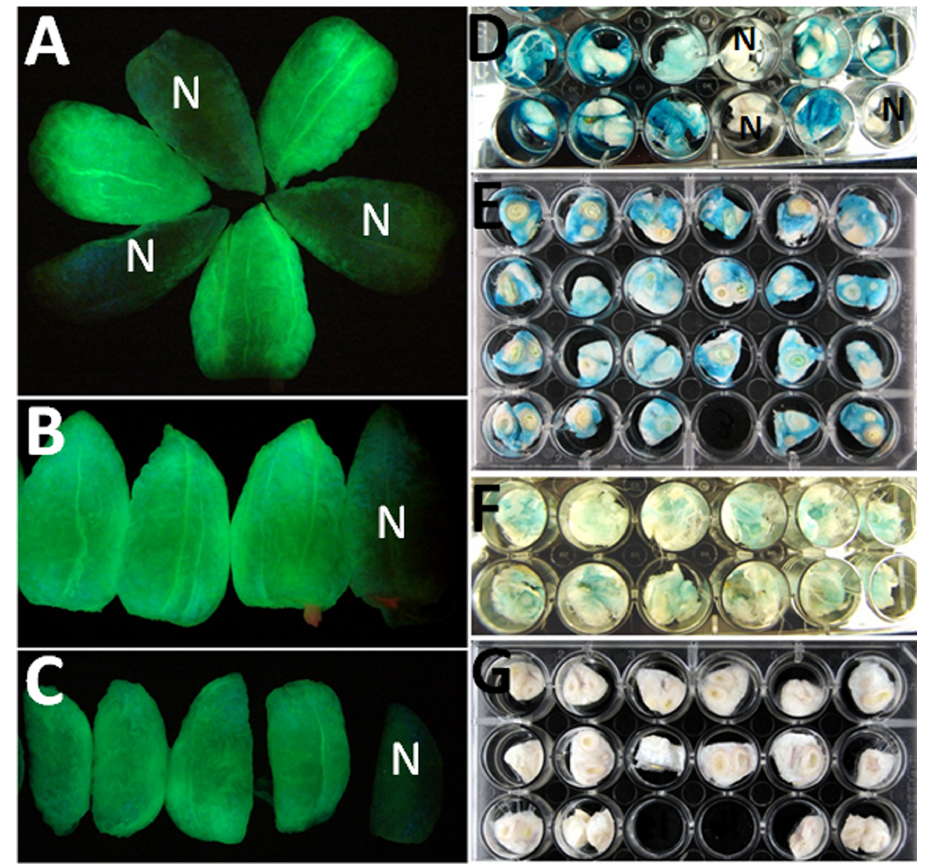
the transgenic cotton fiber tissues of (A) C30 (CelA1::GFP), (B) C31 (LTP::GFP) and (C) C32 (Fb late::GFP) transgenic plants. The dark, non- fluorescence fiber tissues were from null transgenic plants (labeled N). D-G, GUS histochemical staining of cotton fiber tissues harvested from individual transgenic plants of: (D) a T 2 family showing the segregation of reporter gene; a T 3 family from a homozygous transgenic T 2 plant showing uniform and different levels of GUS gene expression at (E) mid and (F) later fiber developmental stages; (G) a